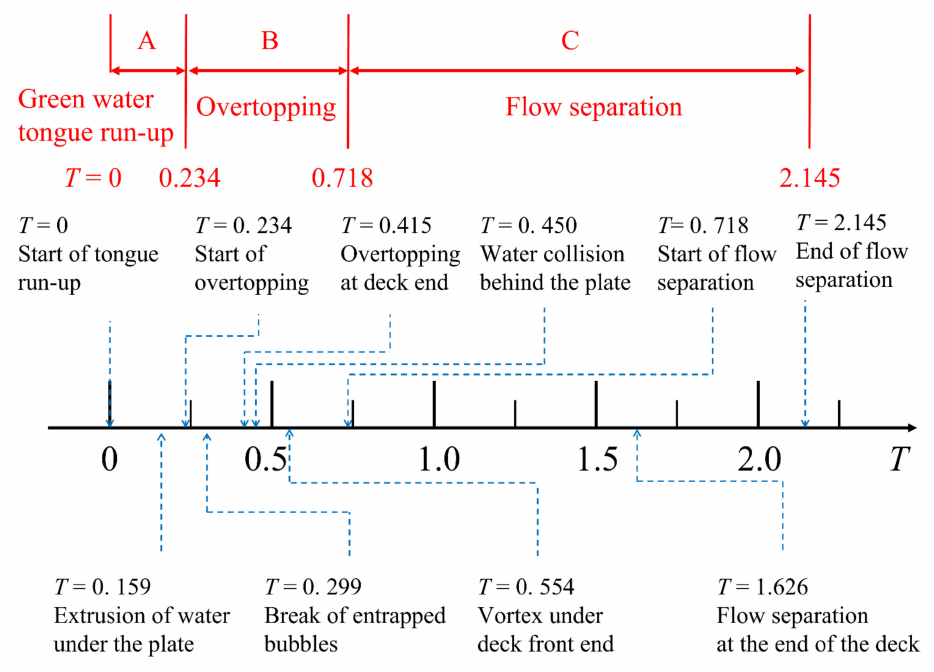
Figure 5. Chronological sketches for green water evolution in the solitary wave (Case 1). Based on the measured velocity, the maximum horizontal velocity U mx , maximum vertical velocity U mz , and the maximum velocity magnitude U mc is calculated. The time history of the maximum velocity is shown in Figure 6, where the vertical error bars represent the standard deviation of experimental repeated measurements. The velocity is normalized with C 0 , as C 0 is defined in Equation (5) mentioned before as 0.68 m/s in this case. Generally, the green water process is presented to be dominated by the horizontal velocity. After the wavefront impact with the plate front side, the horizontal velocity increases significantly. At T = 0.61, the horizontal velocity increases to a maximum of 1.59 C 0, and then the horizontal velocity starts to decrease. Different from the horizontal velocity, the trend of vertical velocity is more complex. With the wave tongue runup along the front side, the vertical velocity shows a rapid increase (0 < T < 0.18). Then, with the splashed tongue falling and attached to the top side of the plate, the maximum vertical velocity declines. After T = 0.42, flow separation starts to occur, causing the vertical velocity restarts to increase. With the incident wave passing forward, the vertical velocity decreases gradually. During this whole process, the maximum vertical velocity presents as 0.83 C 0